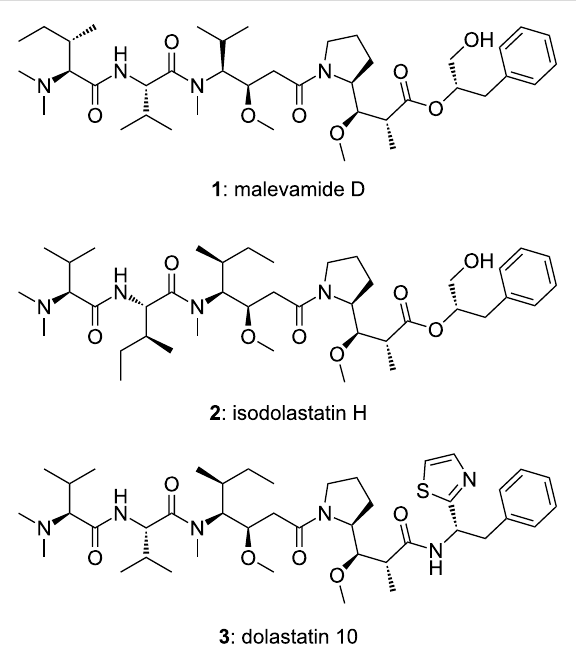
Figure 1: Structures of the strongly cytotoxic marine natural products malevamide D ( 1 ), isodolastatin H ( 2 ), and dolastatin 10 ( 3 ).